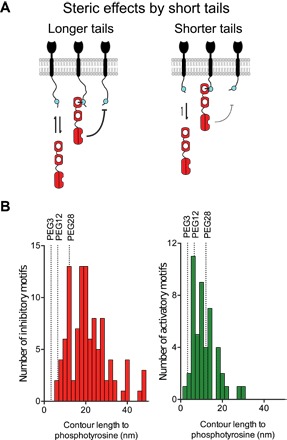
Steric penalty to binding and catalysis by short tethers.(A) Shorter cytoplasmic tails (tethers) result in decreased kon for binding and kcat*(tethered) for catalysis as a result of steric hindrance (indicated by thickness of black arrow). (B) Histograms of the contour length (number of amino acids × 0.3 nm per amino acid) to phosphotyrosine residues on inhibitory receptors (ITIM/ITSM; mean length of 21.2 nm, red histogram) and activatory receptors (ITAM/ITTM/YxxM; mean length of 11.3 nm, green histogram) for human receptors. Most inhibitory receptor tails are longer than PEG28 where steric penalties are lower, whereas most activatory receptor tails are shorter than PEG28 where steric penalties are higher.